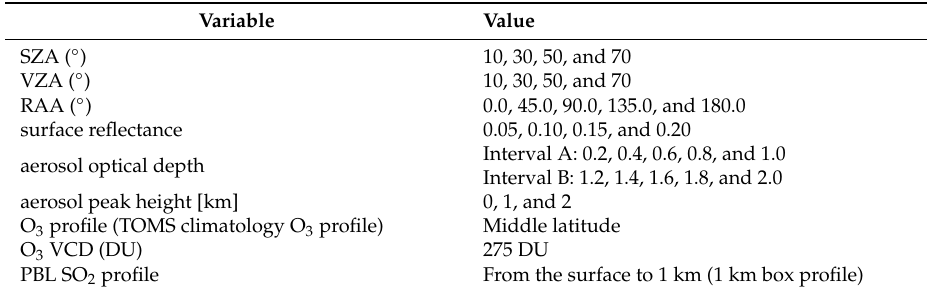
Table 3. To calculate the error budget in thin and thick aerosol cases, two AOD intervals (interval A: 0.2 ≤ AOD ≤ 1.0; interval B: 1.0 < AOD ≤ 2.0) were considered. In addition, the SO 2 AMF was found to be a ff ected by the APH relative to the SO 2 layer height, and three APH conditions (0, 1, and 2 km) were considered in our error analysis. For the APH, AOD, and surface reflectance, the new SO 2 AMF was simulated using X i + σ Xi . ∂ X i denotes the di ff erence between the true X i and X i + σ Xi , and ∂ AMF is the di ff erence between the ‘true’ AMF simulated with ‘true’ input values and the new AMF simulated using input parameters, with the uncertainty of each parameter being X i + σ Xi . Table 3. Variables and values used in calculating the PBL SO 2 AMF error budget related to uncertainties in the APH, AOD, and surface reflectance based on the TROPOMI measurements.